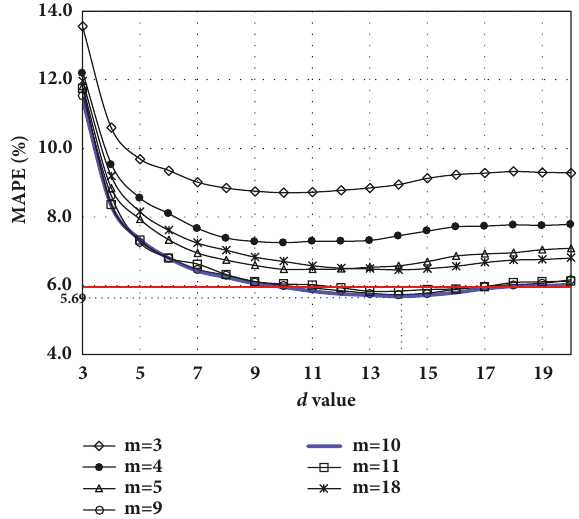
Figure 6: Effects of 𝑚 and 𝑑 values on estimation error rates.